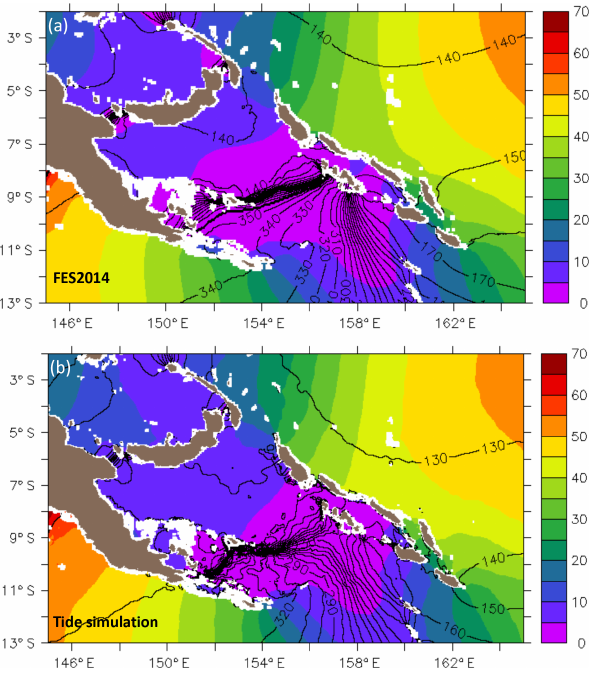
Figure 7. SSH M2 barotropic tide from (a) FES2014 and (b) the R36Th simulation. Amplitude is in color (unit: centimeters) and the contours are phase lines. Isobathymetric lines are from the NOAA/ETOPO bathymetric file from the Smith & Sandwell database (https://doi.org/10.7289/V5J1012Q, National Geophysical Data Center, 2006). White color is for bathymetry of less than 50m.